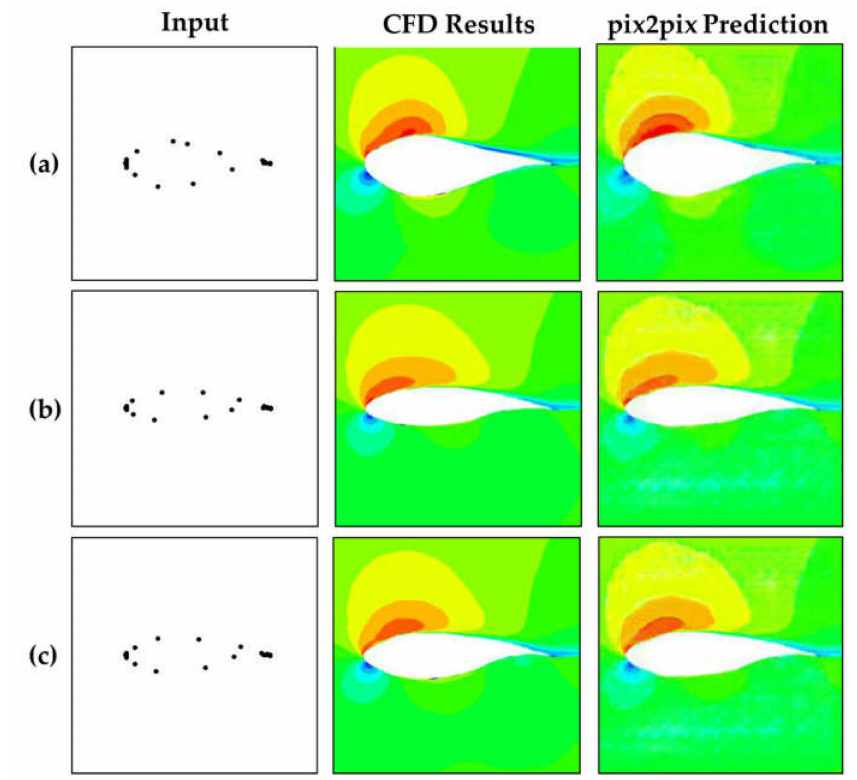
Figure 6. Prediction results of pix2pix for the flow fields of three airfoil shapes with a constant angle of attack (10 ◦ ) and Reynolds number (1.5 × 10 6 ): ( a ) DU 97-W-300, ( b ) DU 91-W2-250, and ( c ) DU